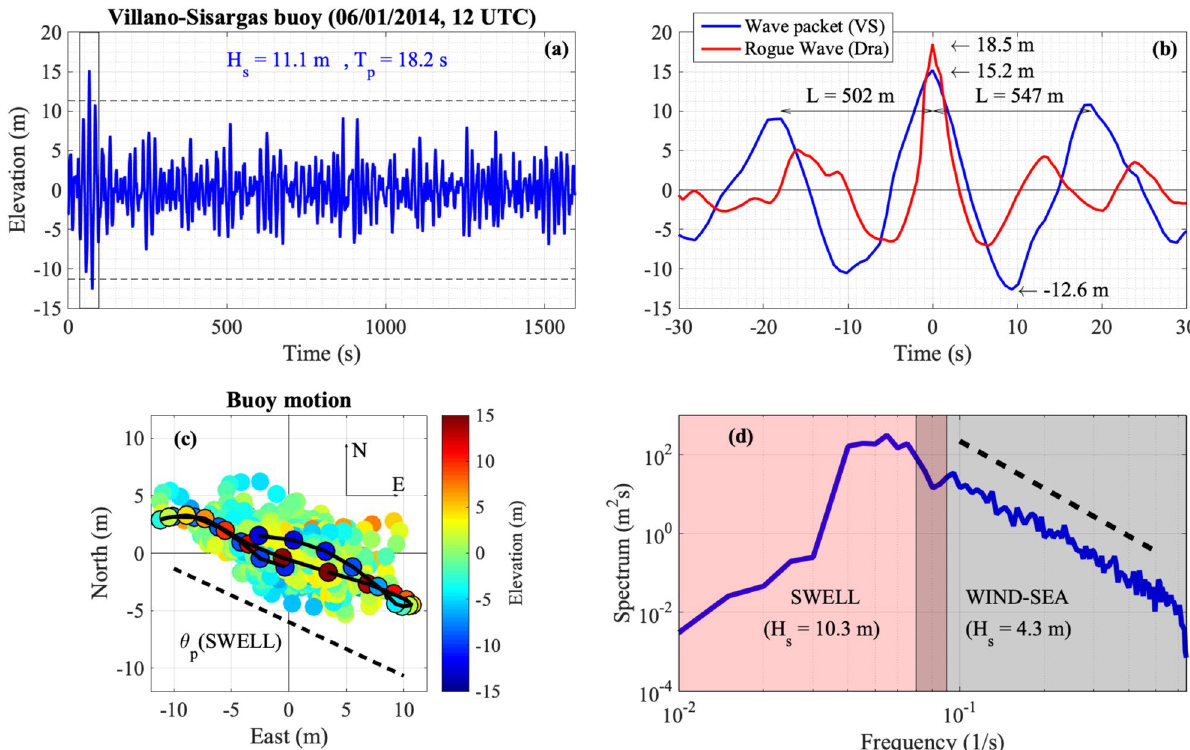
Figure 1. Measurement in the Gulf of Biscay. ( a ) The time series of sea surface elevation showing the giant wave packet. ( b ) A comparison of the famous Draupner rogue wave (red line) and the giant wave packet measured in the Gulf of Biscay (blue line). Time in the horizontal axis has been shifted in order to display the crest of the largest waves at time t = 0 . The distance L between the crests is obtained by means of the linear dispersion relation. Arrows indicate crest heights and trough depth. ( c ) East–North displacement of the buoy for the whole record (circles) and between the two troughs across the maximum elevation (edges circles). The marker colour is proportional to the surface elevation. ( d ) The frequency spectrum has been computed on the time series using standard FFT routine. Averages over samples of 1024 points ( (cid:31) t = 0.78 s) with overlap of 50 % have been performed. The logarithmic scale spectrum shows a clear peak at 0.054 Hz which corresponds to a period of 18.5 s 18